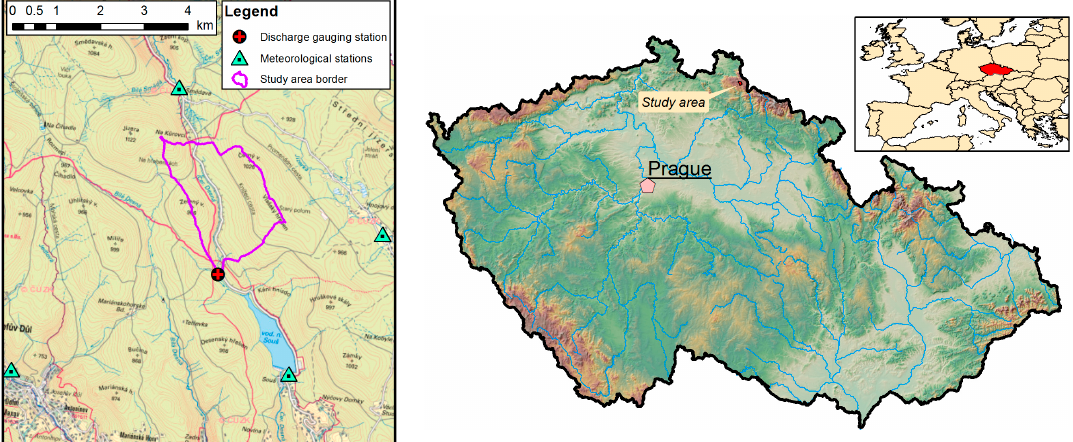
Figure 1. The study area with the location of meteorological and discharge gauging stations ( left ) and location of the study area in the Czech Republic ( right